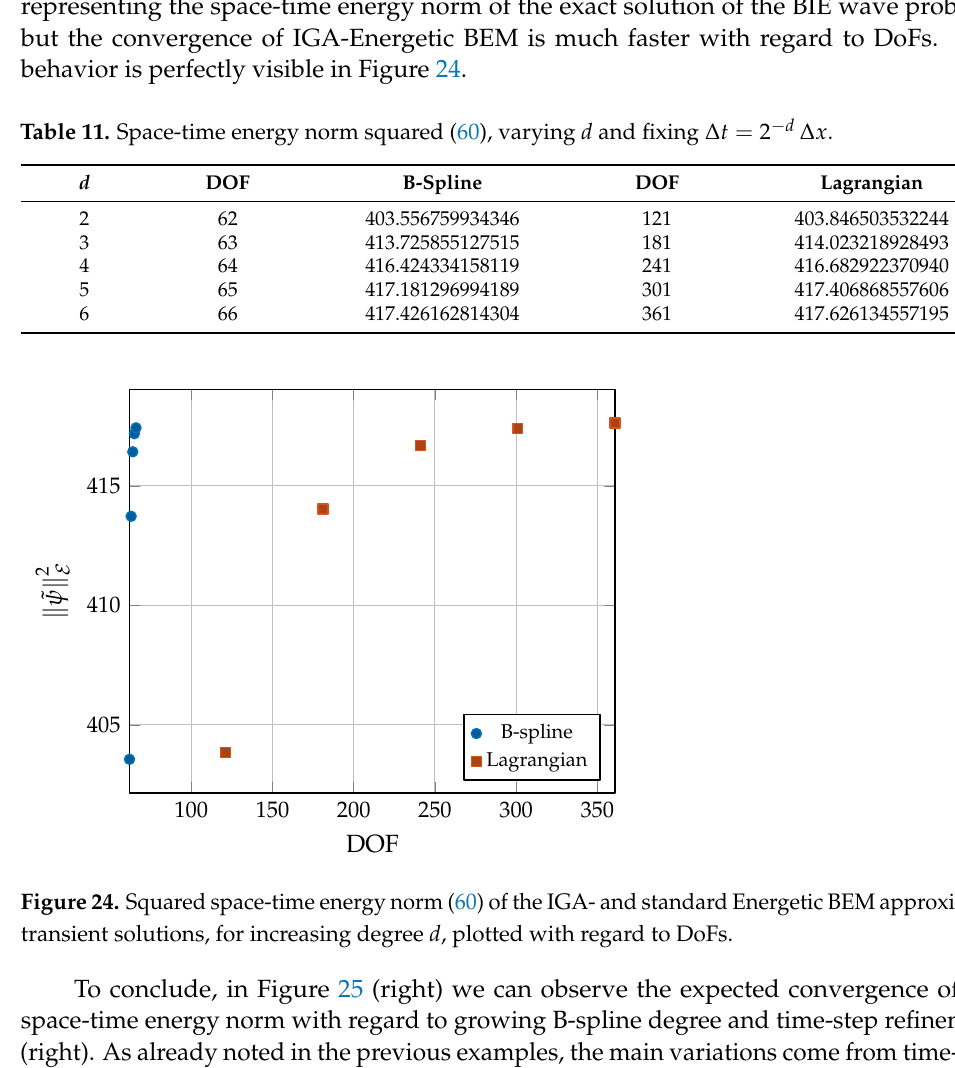
Figure 24. Squared space-time energy norm (60) of the IGA-Energetic BEM and standard Energetic BEM approximate transient solutions plotted w.r.t. DoFs